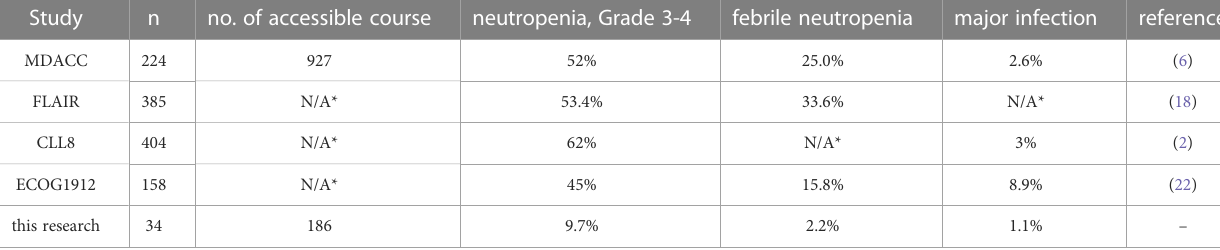
TABLE 5 The incidence of neutropenia in prospective studies related to R-FC.